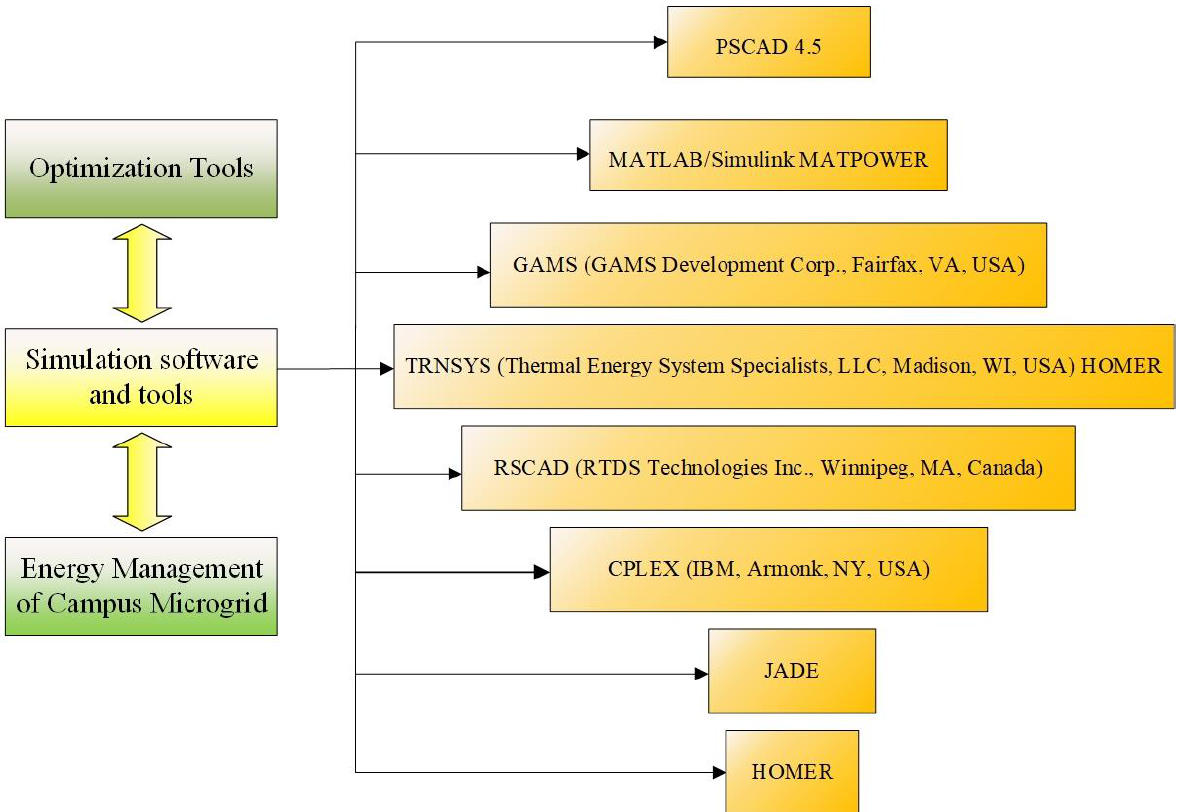
Figure 10. Simulation tools used in the energy management of campus microgrids.